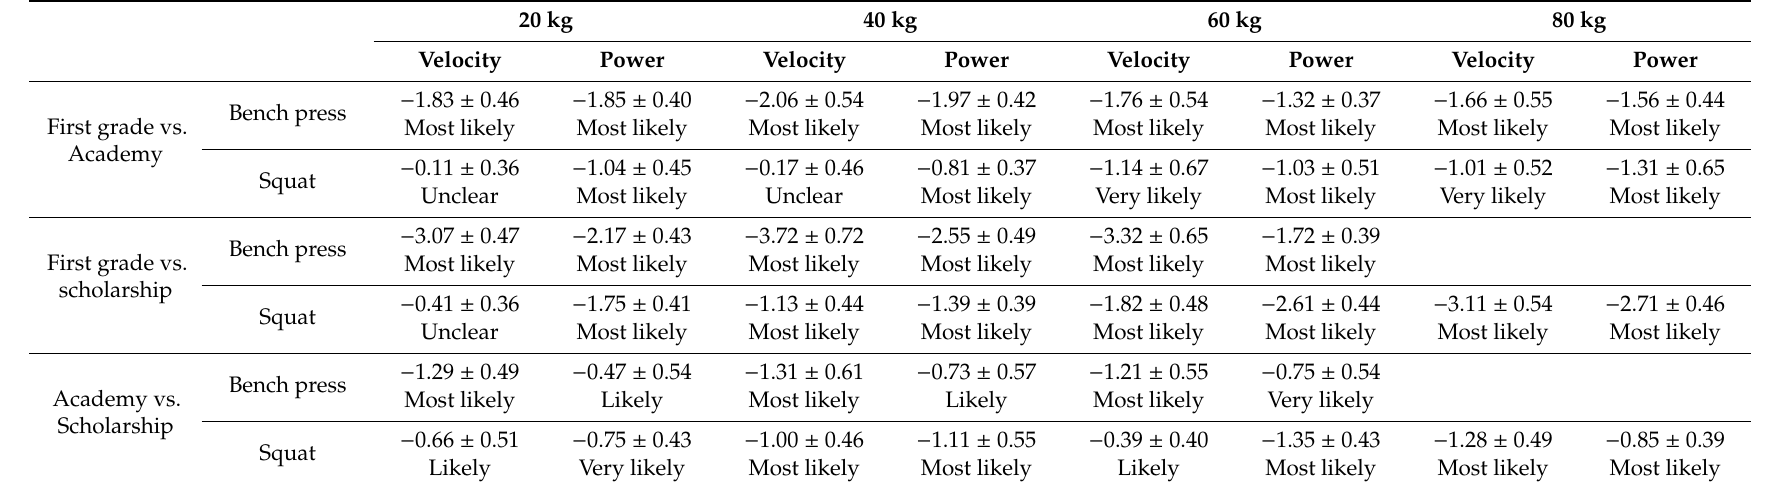
Table 2. Qualitative interpretation and e ff ect size (ES) ± confidence interval (CI) for the interpretation of dependent variables during the bench press and squat